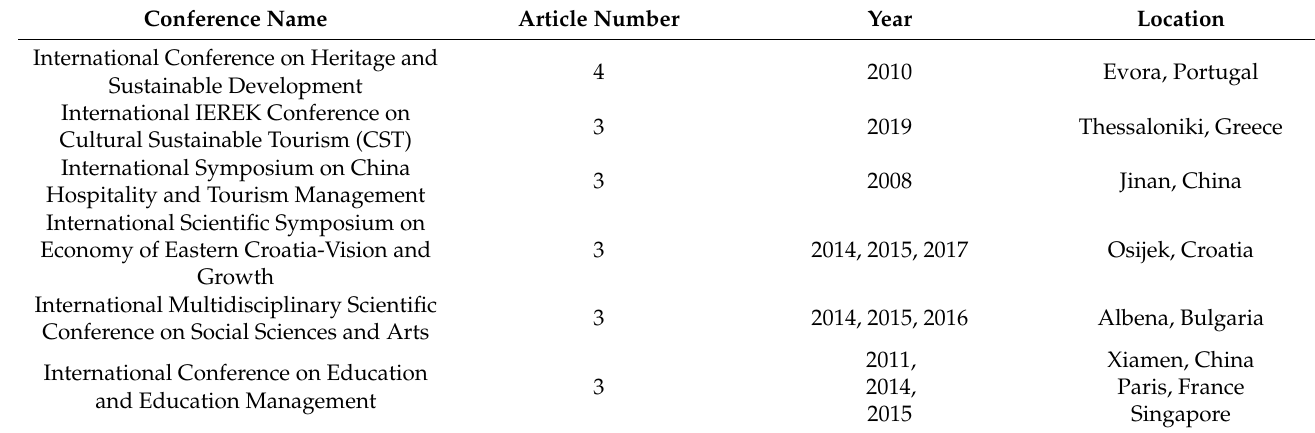
Table 3. Conferences with more than three articles.